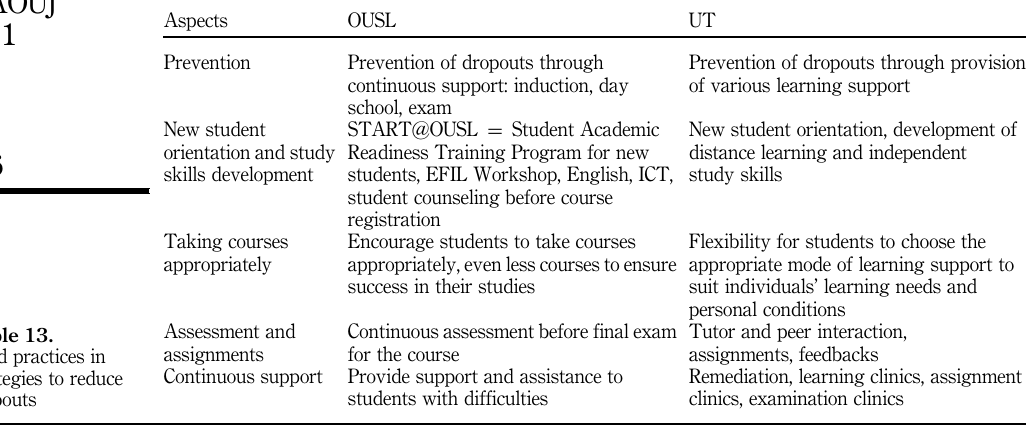
Table 13. Good practices in strategies to reduce dropouts